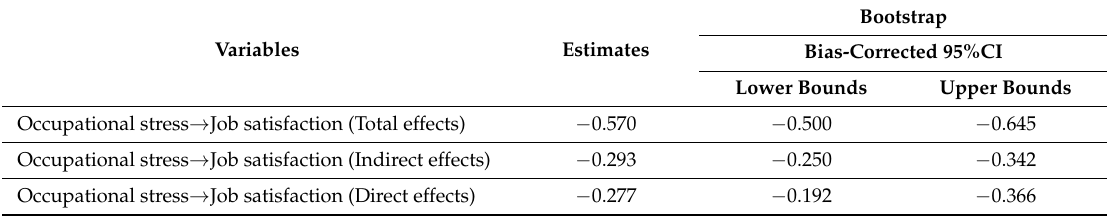
Table 4. Mediating role of PsyCap on the associations between occupational stress and job